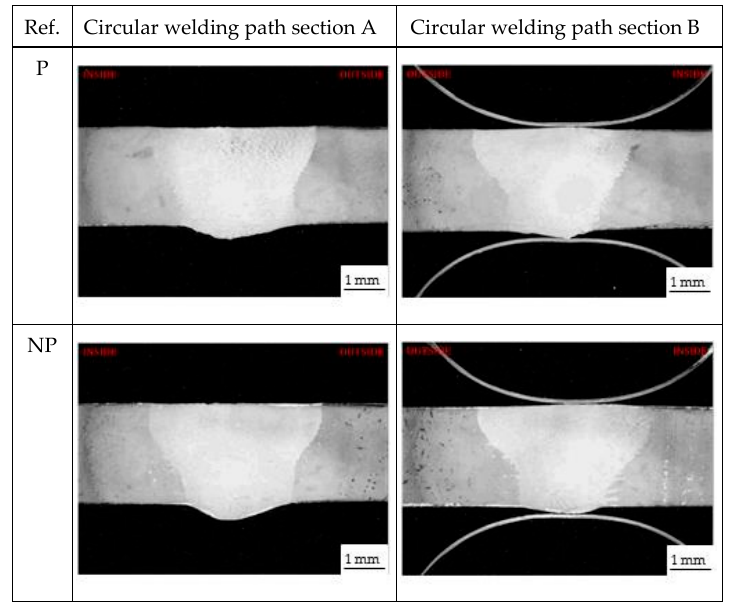
Figure 9. Cross-section of bead-on-plate tests of moulds P and NP with less than 3 mm thickness. Laser power 2050 W.